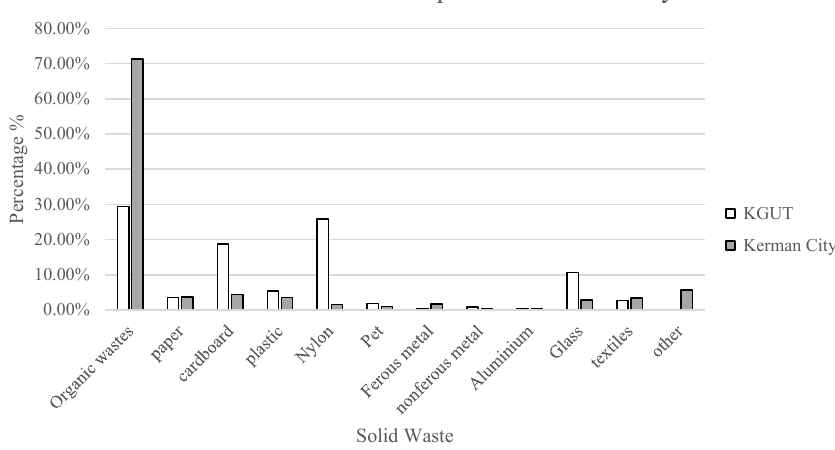
Figure 3. Comparing the wastes produced at Kerman Graduate University Of Technology and Kerman City